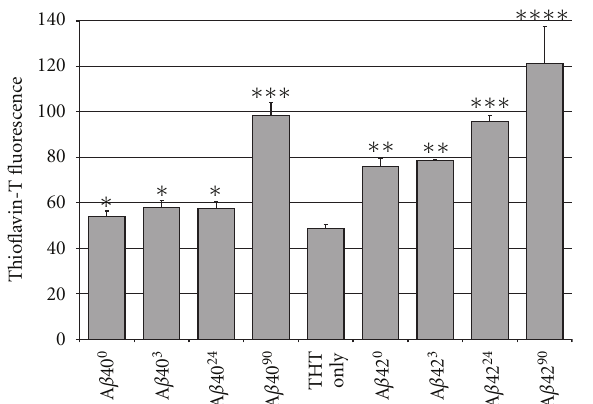
Figure 3: Thioflavin-T fluorescence of A β exposed to endocytic conditions. Significant thioflavin-T fluorescence for the A β 40 90 and A β 42 90 samples indicates the highest level of aggregation present. Error bars represent the range of two independent experiments. Statistical significance is indicated ( ∗ ) P < . 05.